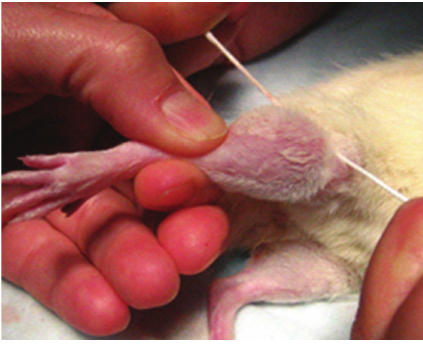
Figure 2: In vivo organ distribution study by DsRed protein fluorescence measurements. The normal female Lewis rats were allocated to 3 groups and each consisting of 3 animals. One group, serving as normal controls, received 4ml of saline injected with the hydrodynamic technique via the femoral vein. Another two Groups received 200 μ g DsRed plasmids DNA prepared with 4 ml saline injected by normal femoral vein injection and hydrodynamic femoral vein injection, respectively. The rats were sacrificed 6 to 8 days following injection. The tissue sections of liver, kidney, and skeletal muscle were removed, cleaned, and homogenised. The samples suspensions were then stored in − 80 ◦ C until the day the measurements are done. The DsRed plasmids DNA, coding for fluorescent emitting proteins, were measured by detecting the emitted DsRed fluorescence wave, with a maximum excitation at 555 nm and maximal emission at 583 nm. The skeletal muscle groups included gluteus superficialis (GS), Femoris Bicep of left and right hindlimbs (Left BF and Right BF), soleus of left and right hindlimbs (Left S and Right S), and gastro of left and right hindlimbs (Left G and Right G). Values were shown as mean ± SEM of normalised DsRed fluorescence/protein (mg) of 3 rats of each group. All values were subjected to t test and one-way ANOVA analysis. A value of 0.05 was considered significant. The highest value of fluorescent spectra (right soleus muscle section) is set as